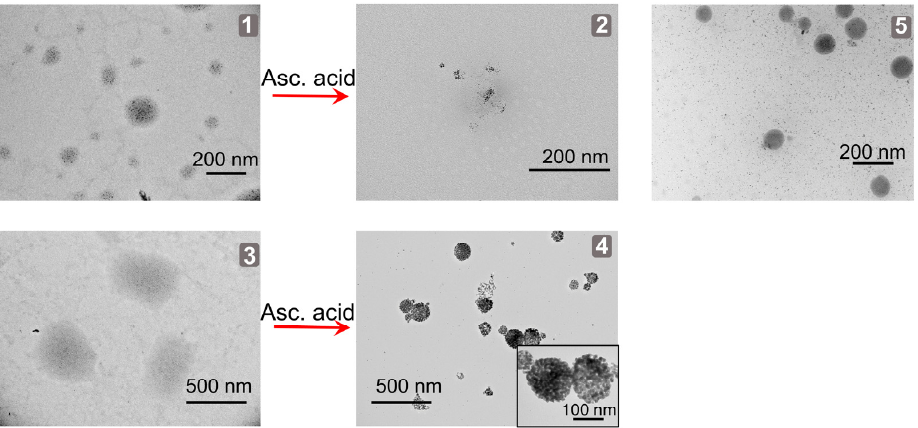
Figure 3. TEM images of 4a before (1) and after (2) treating with ascorbic acid; 4b before (3) and after (4) treating with ascorbic acid, and 3b +K 2 PdCl 4 (5) treated with ascorbic acid, with different scale bars.